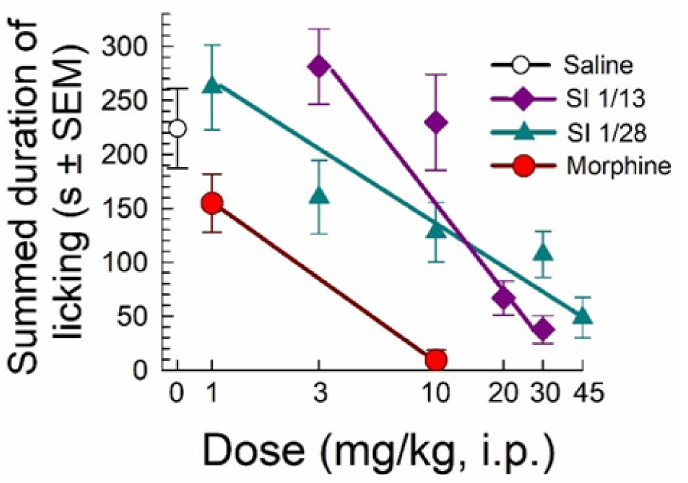
Figure 2. Dose-dependent antinociception of SI 1/28 following i.p. administration in the mouse formalin assay. Control mice were treated with saline (0.9%), morphine or the parent S1R antagonist, SI 1/13. All points represent summed time spent licking ± SEM of 7–13 mice. Note that SI 1/13 data is as previously published in reference